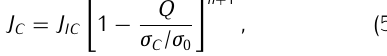
Emergence of various problems in the FEM analysis when large deformation assumptions were used have not dis- couraged researchers in using the maximum opening stress and its distance from crack tip in solving engineering prob- lems. Both parameters (maximum opening stress and its distance from crack tip) were used in the proposals for fracture criteria, what will be presented in the next para-